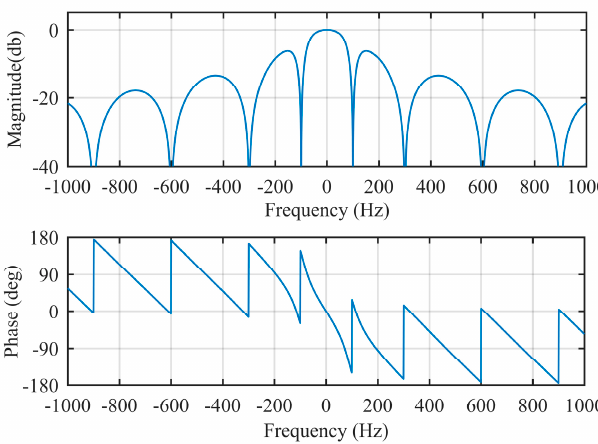
Figure 8. Frequency response of the entire hybrid cascaded filtering stage.